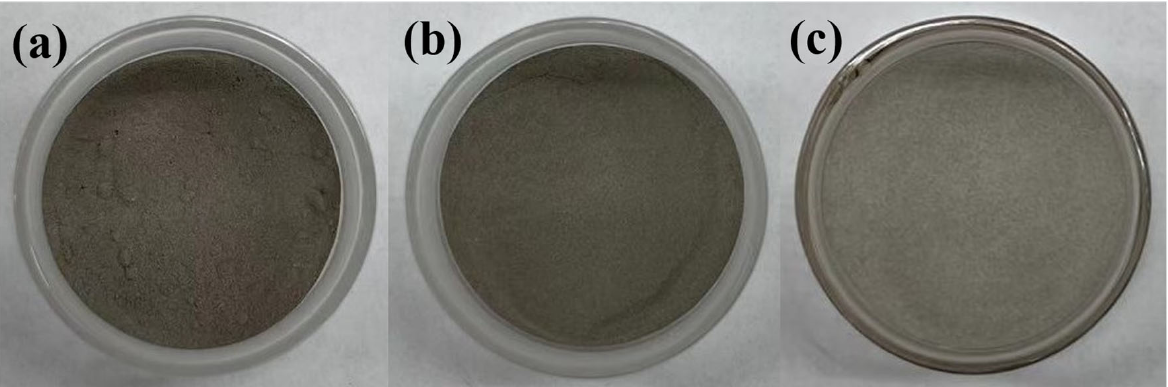
Figure 2. Material images of ( a ) CFA; ( b ) water ‐ washed CFA; and ( c ) NaOH ‐ CFA.